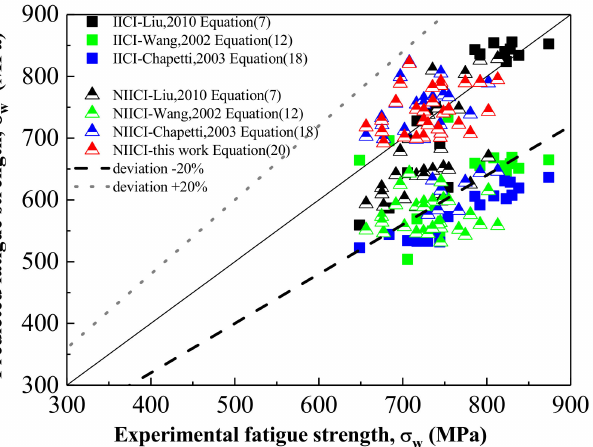
Figure 12. Comparison of experimental and predicted fatigue strengths of steels using exiting formulae, solid points for IICI estimation and triangle points for NIICI estimation